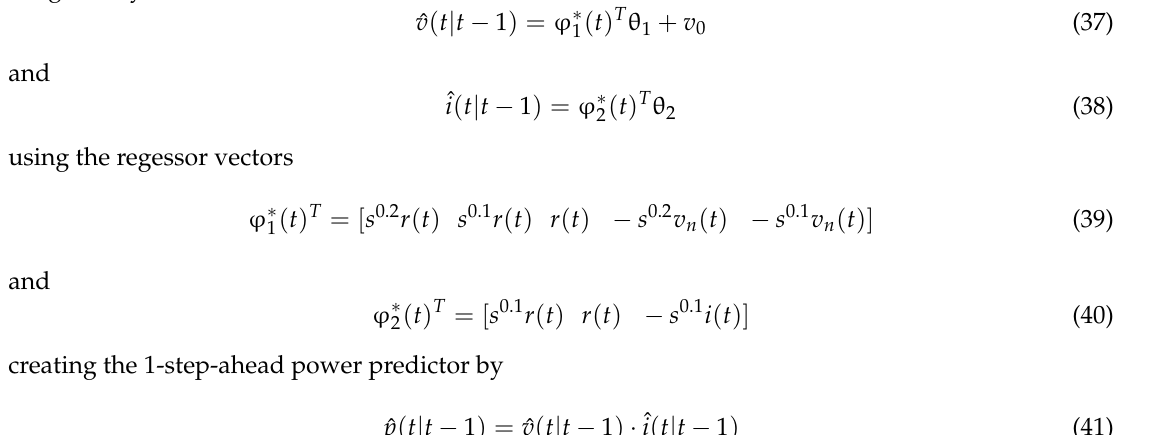
Figure 7. Squared prediction error of voltage model ε 2 function of fractional differential order α